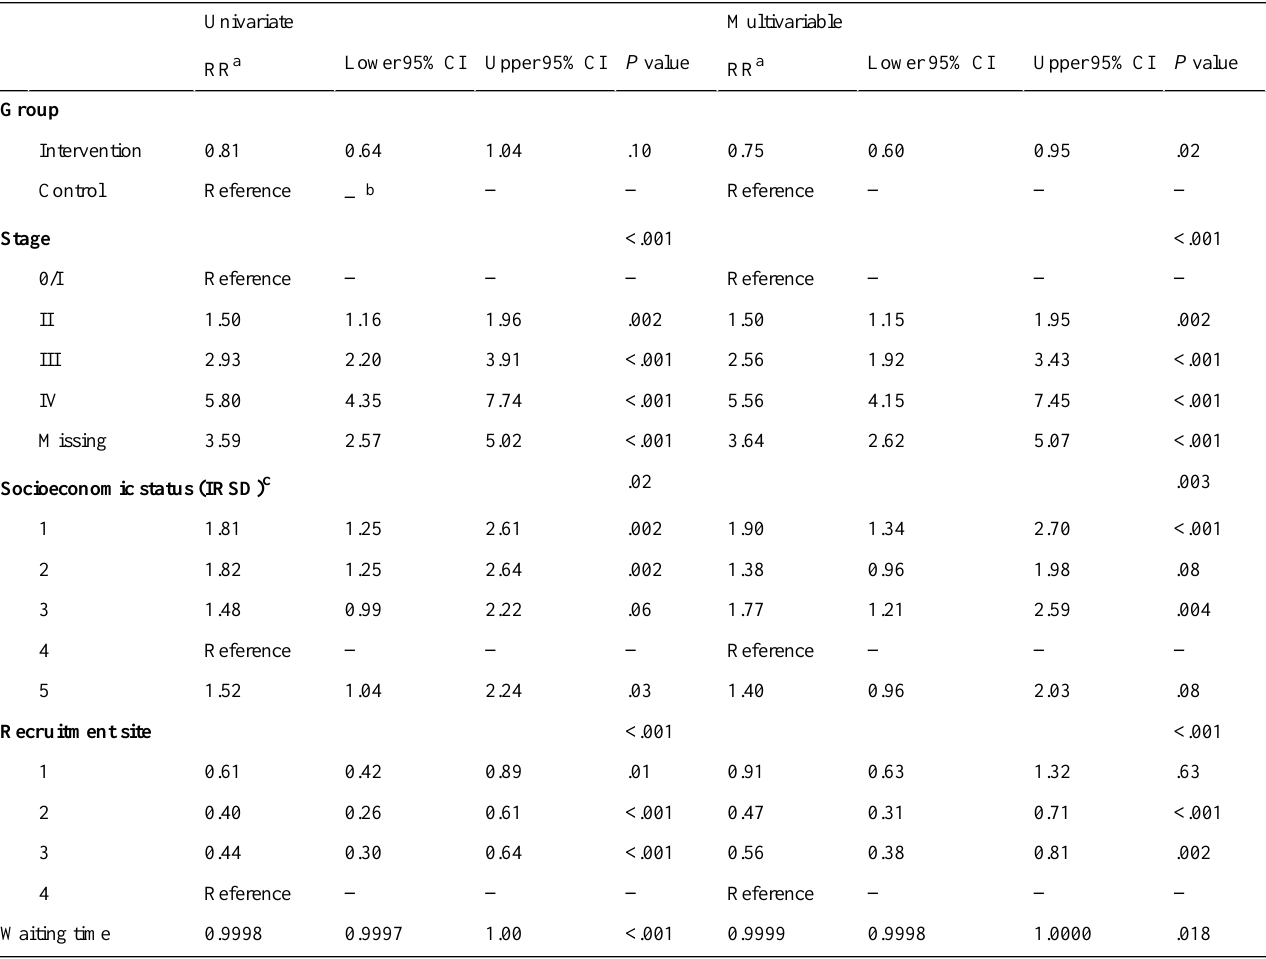
Table 2. Comparison of emergency department presentations using negative binomial regression. Patients matched for age, sex, and treatment status.